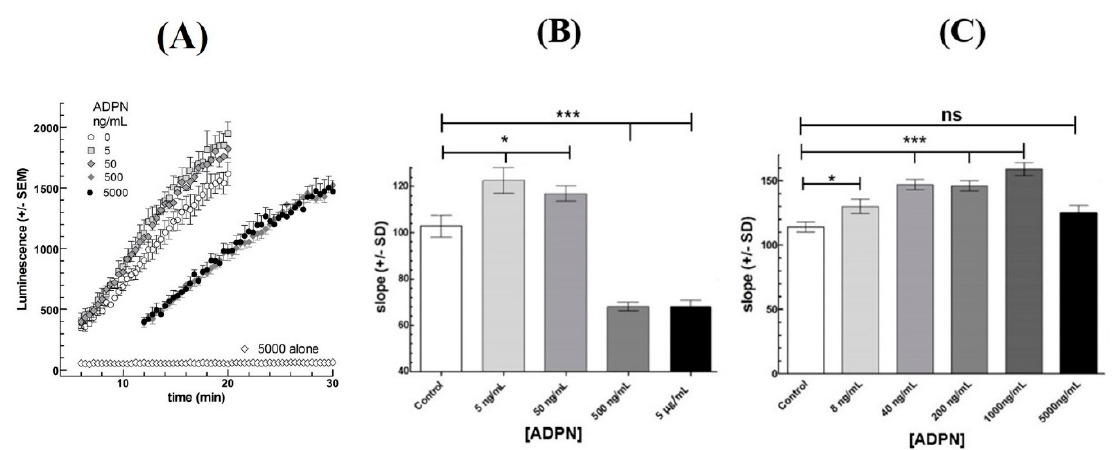
Figure 3. Effect of adiponectin (ADPN) on the cAMP response to 0.7 nM hLH in Mouse Leydig Tumor cells (mLTC)-1 cells. ( A ): Kinetics of oxyluciferin luminescence produced by cyclic AMP-dependent luciferase in mLTC-1 cells stimulated by 0.7 nM rec hLH after 1h-preincubation with the shown concentrations of ADPN. ( B ): Dose-response effects from kinetics in panel (A). ( C ) Dose-response effect of 1h-preincubation with frozen and thawed ADPN on the cAMP response to 0.7 nM hLH. Each point represents the mean of luminescence in six wells in each condition. The figure presents one representative experiment out of three independent experiments. After checking of normality of distribution, the data were analyzed by a paired Student’s t-test. * indicates a significant difference (* p < 0.05, *** p < 0.001) compared between each ADPN concentration and control (hLH alone), ns = not statistically significant.